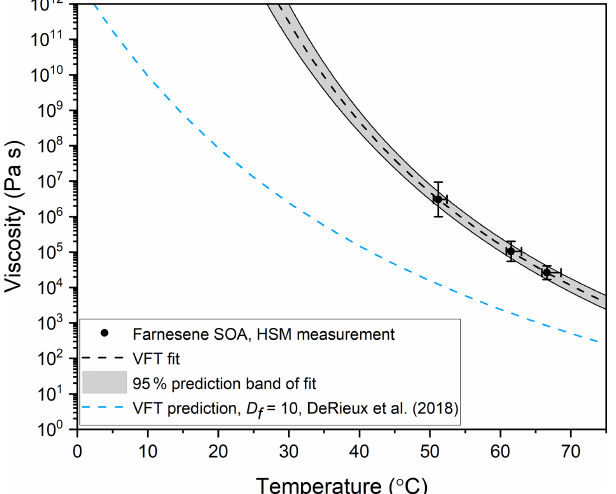
Figure 8. Viscosity as a function of temperature for farnesene SOA material. The black data points represent the midpoint of the upper and lower limits of viscosity, measured with hot-stage microscopy (HSM). The y -error bars correspond to the calculated upper and lower limits of viscosity from at least two separate experiments. The temperature uncertainty ( x error) is a propagation of the un- certainty in the temperature control stage calibration and the largest temperature oscillation during the experiment. Note that the x -error bars are asymmetric because the largest temperature oscillation was always toward hotter temperatures. The black dotted line is a VFT fit to the HSM measurements, with the grey area representing the 95% prediction band of the fit. In the VFT fit, D f and T 0 were left as free parameters, while A was fixed at − 5. This fit was extrapo- lated to 10 12 Pas, yielding a T g of 302K. The blue dashed line is the prediction using the method in DeRieux et al. (2018) with HRMS data and of D f = 10, which yields a T g of